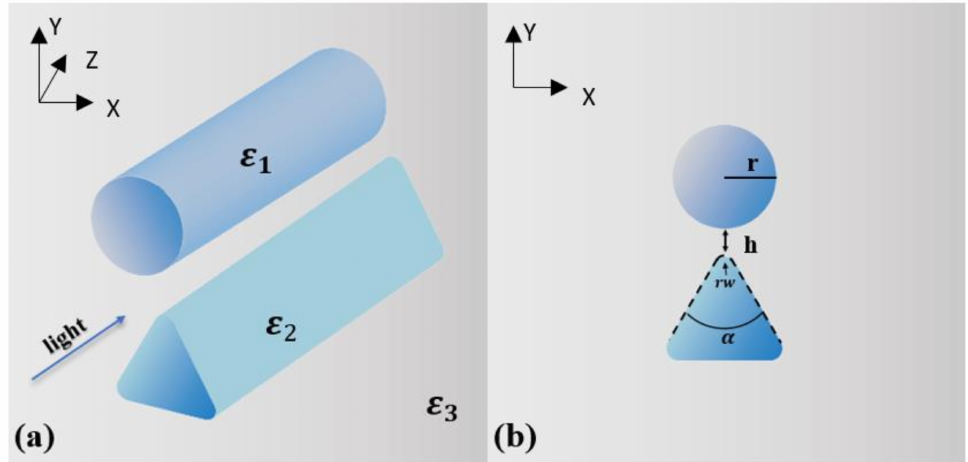
Figure 1. Schematic illustration of the proposed HPW consisting of a cylinder silicon nanowire located above a sliver triangle structure with a silicon dioxide gap of height, h between them: ( a ) schematic of the 3D geometry; ( b ) 2D cross-sectional